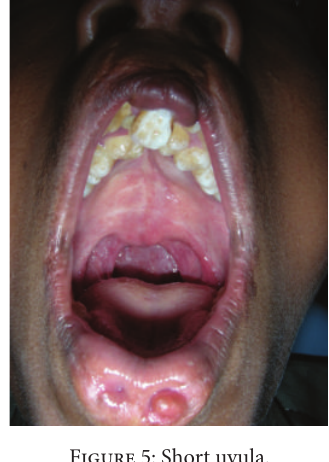
Figure 5: Short uvula.